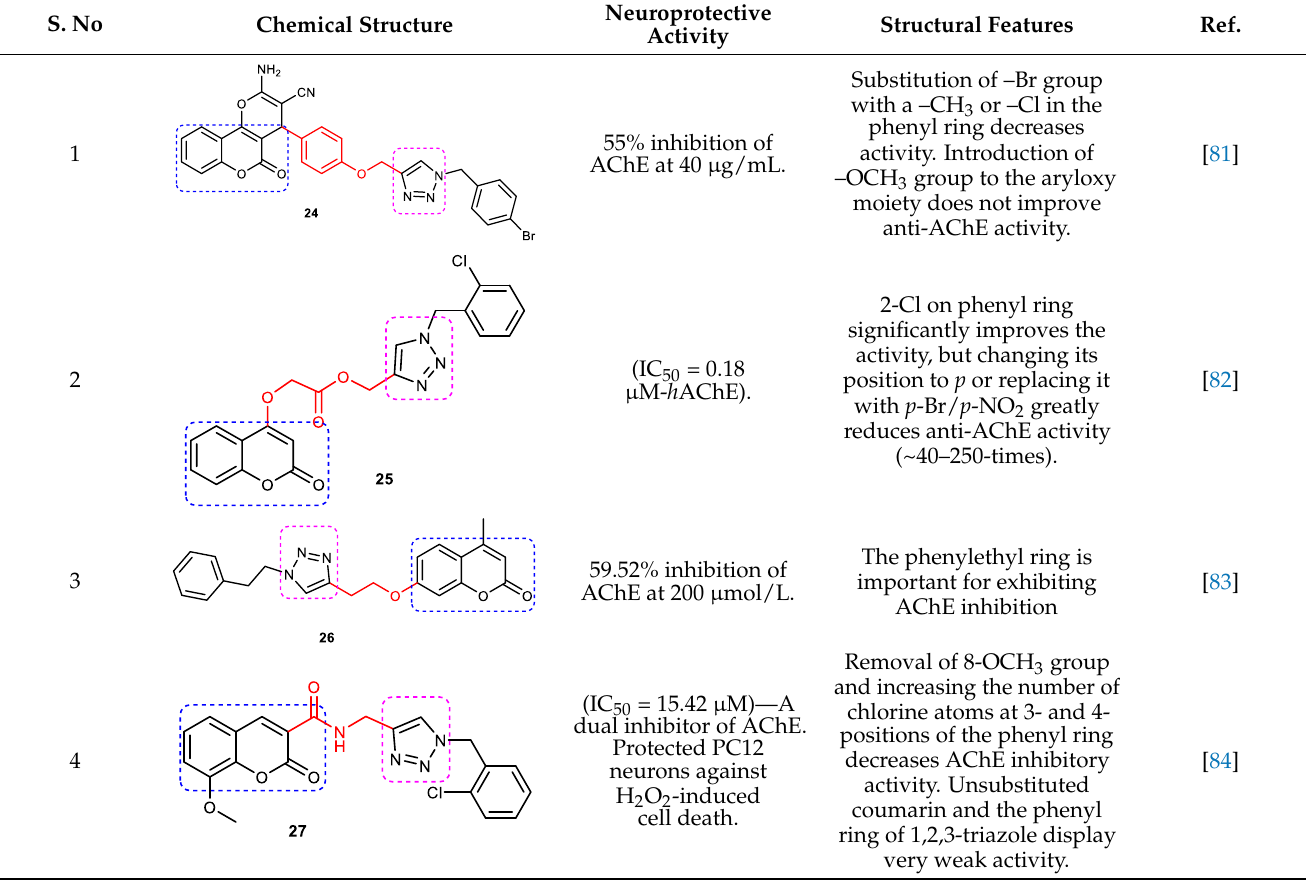
Table 2. Chemical structure and mechanism of the neuroprotective activities of some selected cou- marin – 1,2,3-triazole derivatives.